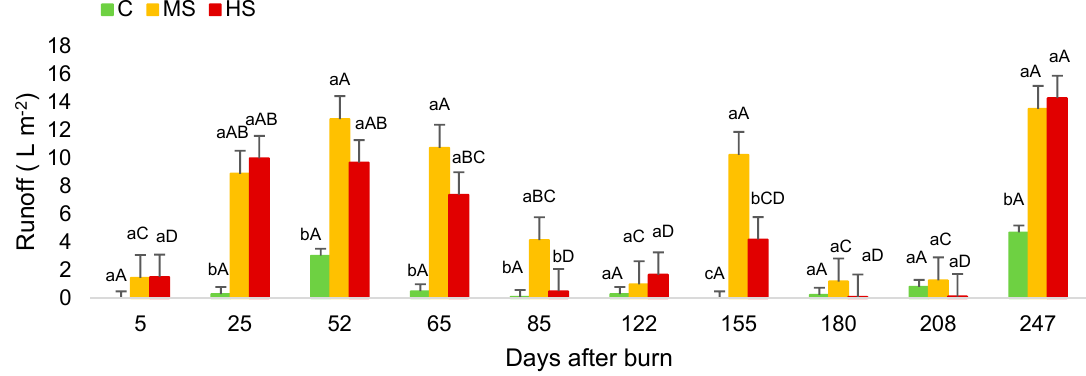
Figure 2. Treatment effect under control (C), moderate severity (MS), and high severity (HS) burn on runoff (L m − 2 ) between 5 and 247 days after pile burning. Mean values followed by the different lowercase letters show significant differences within the same date. Mean values followed by the different uppercase letters show statistically significant differences within the same treatment.